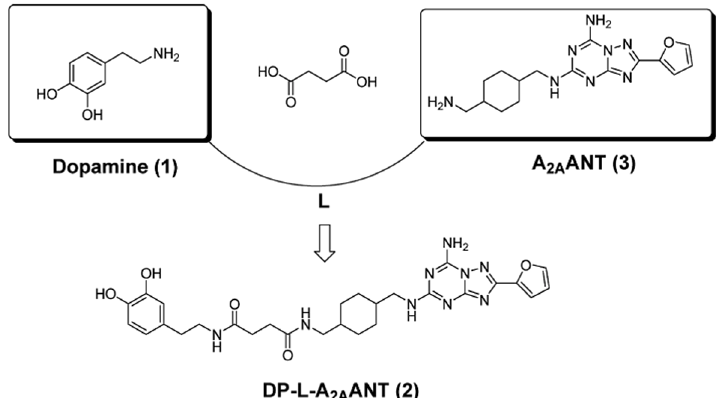
Figure 4. Conjugation of dopamine with the A2A antagonist 7-amino-5-(aminomethyl)-cyclohexylmethyl-amino-2-(2-furyl)-1,2,4-triazolo[1,5-a]-1,3,5-triazine trifluoroacetate via a succinate spacer, to obtain the prodrug DP-L-A2AANT, a bivalent ligand [394]. The potent A 2A R antagonist ZM 241385 and the D 2 R agonist ropinirole are considered to have favorable properties for the design of bivalent therapeutic drugs. These classic ligands were used in 2015 to synthesize a novel series of compounds [395] (Figure 5). A cyclic linker between the A 2A and D 2 pharmacophores could be used to increase the struc- tural rigidity of a bivalent ligand. Generally, triazine-linker based members of the family showed a 4-fold decrease in A 2A inhibitory potency compared to the parent A 2A R antago- nist and maintained their functional potency towards the D 2 R. Non-cyclic dual acting lig- ands showed a 28- to 54-fold reduction in their A 2A R inhibitory potency. Many of the de- veloped compounds passed preliminary BBB permeability tests. However, the in vivo brain uptake kinetics of these dual acting ligands should still be determined [395].